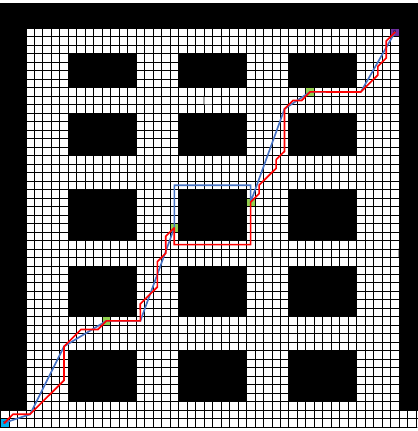
Figure 5. Multi-objective path planning.